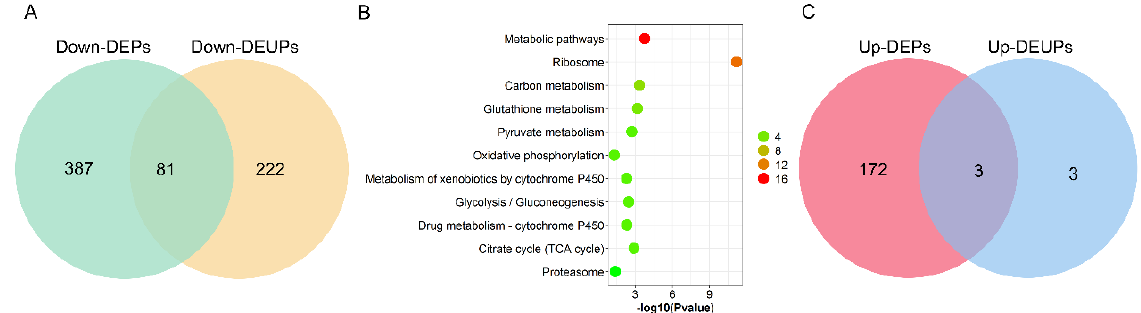
Figure 6. The correlation analysis between differentially expressed proteins and differentially ex- pressed ubiquitinated proteins due to Wolbachia infection in the testis of D. melanogaster . ( A ) Venn diagram of the correlation numbers between downregulated proteins and downregulated ubiqui- tinated proteins. ( B ) GOBP enrichment of overlapped downregulated proteins and downregulated ubiquitinated proteins. The color indicates the difference in protein counts. The redder the color, the more the count; the greener the color, the less the count. ( C ) Venn diagram of the correlation num- bers between upregulated proteins and upregulated ubiquitinated proteins.